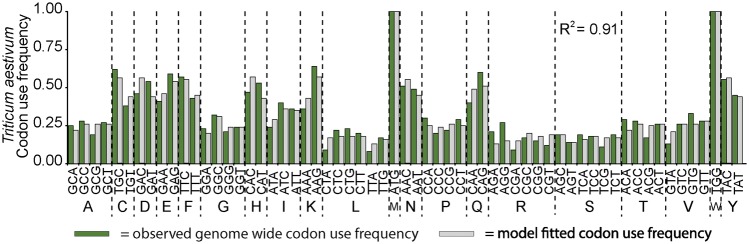
A comparison of model-fitted and genome wide patterns of synonymous codon use. Example shown is from Triticum aestivum. The calculation of the coefficient of determination (R2) did not include amino acids with only one codon (M or W). T. aestivum was chosen as it is close to the average R2 value of the species analyzed. The complete set of plots can be found in supplementary file S3, Supplementary Material online.